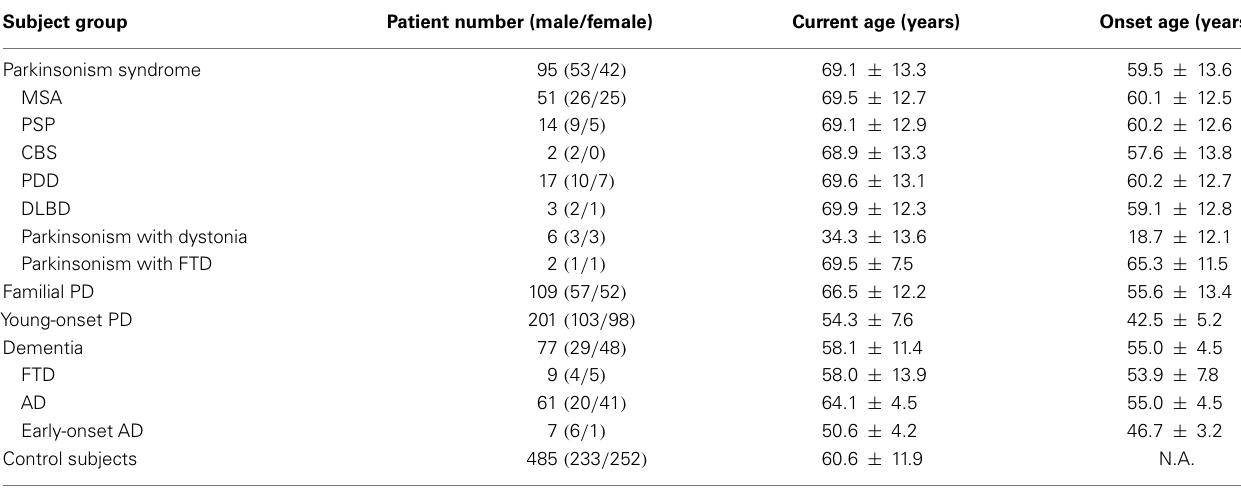
Table 1 | Demographic data of the enrolled subjects in each disease group .